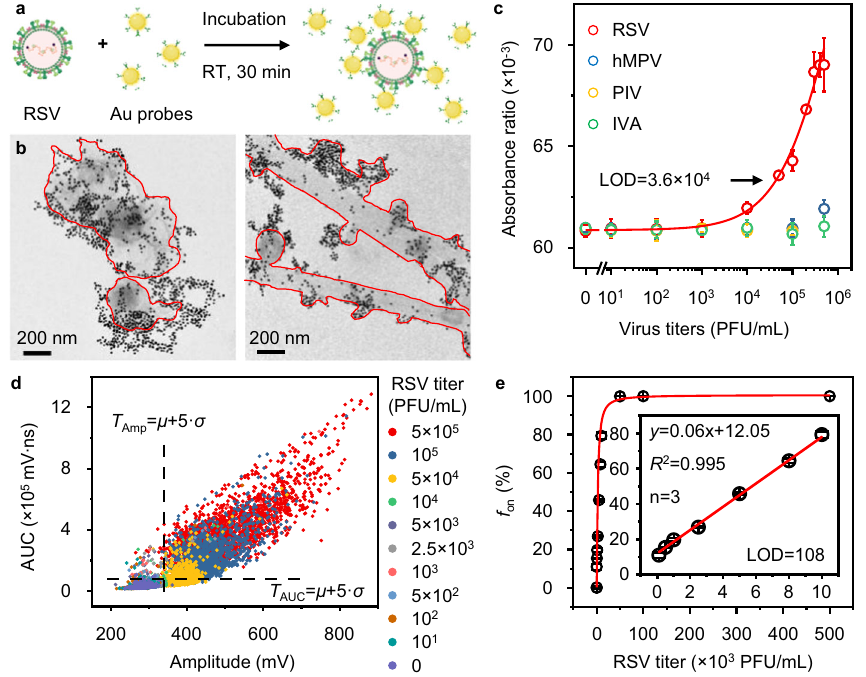
Fig. 5 Detection of respiratory syncytial virus (RSV) in a one-step homogenous immunoassay by DIAMOND. a The schematic illustration of a homogeneous immunoassay for RSV utilizing antibody-conjugated AuNPs as probes at room temperature (RT). b TEM images of AuNP probes targeting RSV. The boundaries of RSV were highlighted in red. c Colorimetric analysis of the AuNP-based homogeneous immunoassay for different respiratory viruses. hMPV is Human metapneumovirus, PIV is Parain fl uenza viruses, and IVA is In fl uenza A. d Bivariate plot of amplitude and AUC extracted from 3000 pulses for the assay solutions with RSV at different titers (PFU/mL). Dashed lines indicate the positions of thresholds calculated from the control sample. e Quanti fi cation of RSV titers as a function of f on . Inset shows the linear detection range. Error bars in ( c ) and ( e ) indicate the standard deviations of three independent measurements, the data were fi tted by logistic fi tting, and the LOD was calculated as 3 standard deviations of the control divided by the slope of regression